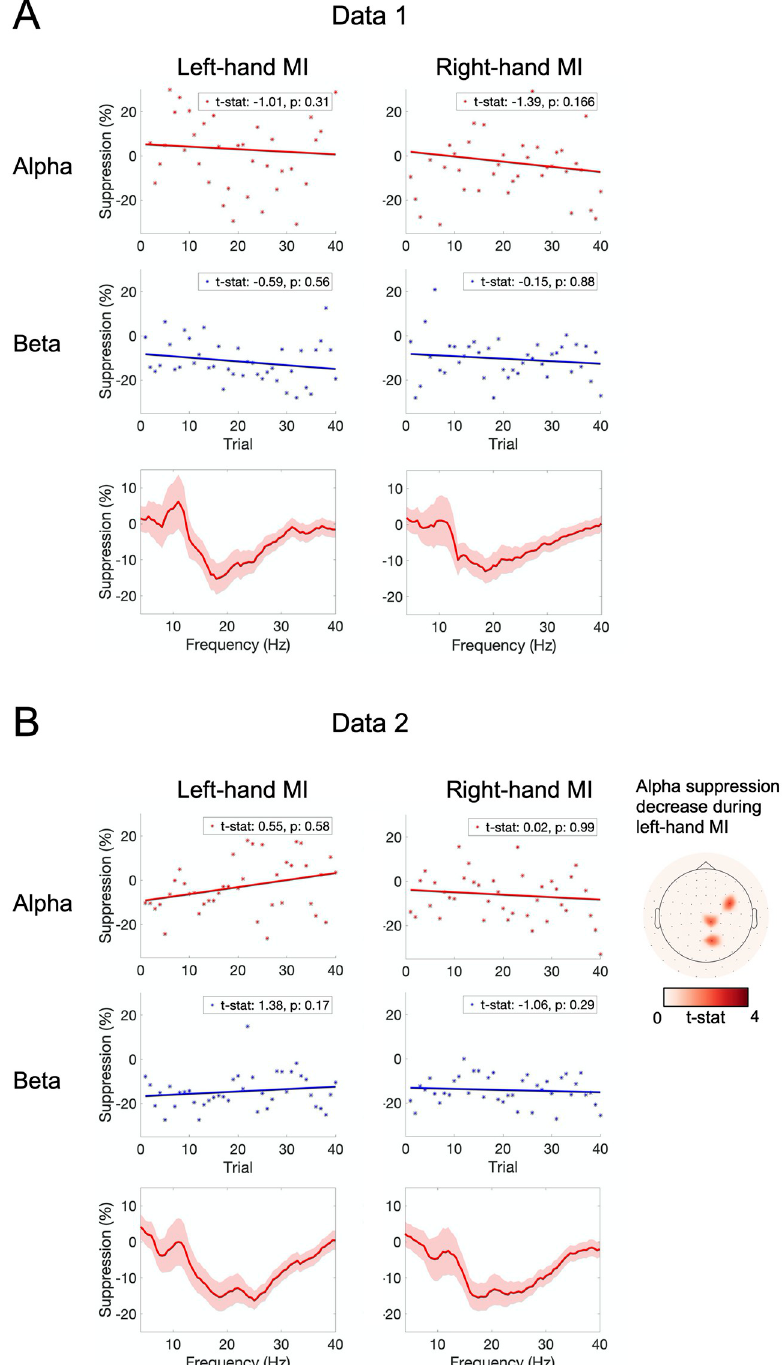
Fig 8. Suppression of alpha and beta frequencies during MI. Alpha and beta suppression for each trial for left- and right-hand MI, and suppression at each frequency in range 4–40 Hz, in (A) Data 1 (visual feedback), (B) Data 2 (proprioceptive feedback). The solid lines show linear regression. T -statistics and p -values obtained from GLM are shown in each plot. In the frequency-specific suppression plots, shaded areas represent the standard error of the mean (SEM) over subjects. For Data 2, the channels in which alpha suppression decreased over training are shown in the rightmost column. All analyses are done using only the data from parietal gradiometers.